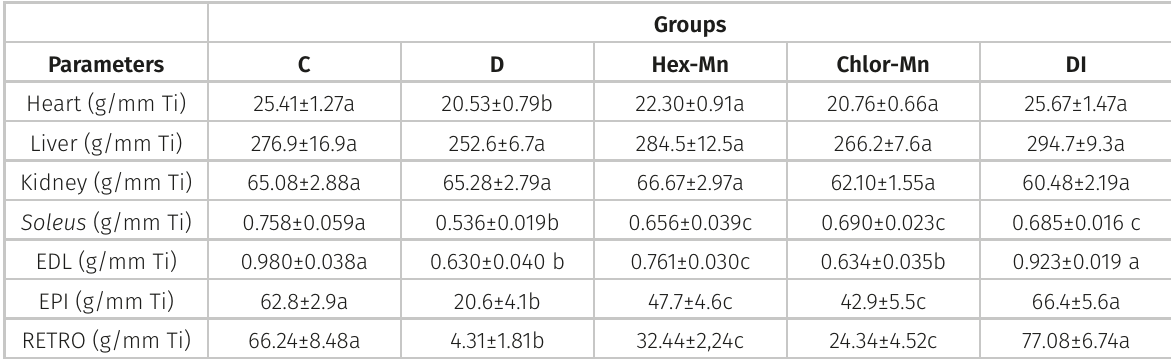
Table II. Effects of Hex-Mn and Chlor-Mn fractions on heart, liver, kidney, soleus , EDL, EPI and RETRO organ mass in control and diabetic treated for 21 days.